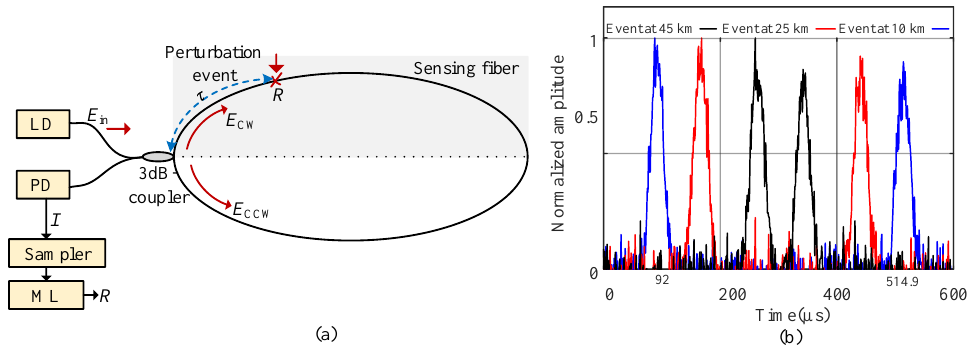
Figure 1. ( a ) SI loop distributed sensor, and ( b ) three normalized noisy signals were captured at the PD output due to three different events. The position of the two pulses for every signal is different. LD: laser diode, PD: photodetector, ML: machine learning Time-delay estimation is another method for event localization in SI loop